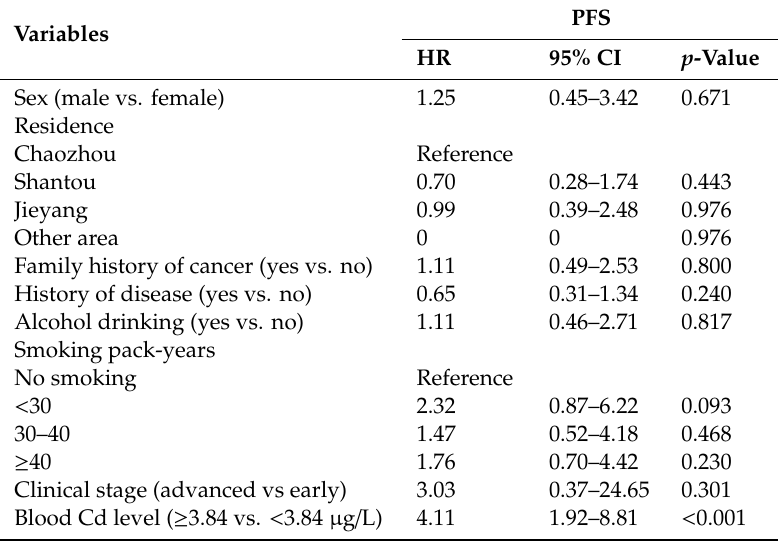
Figure 2. Comparison of PFS among different groups of NPC patients by Kaplan–Meier log-rank test. A–I: PFS by age, disease history, alcohol drinking, T classification, N classification, M classification, pathological type, early antigen-positive (EA+), and VCA, viral capsid antigen antibody-positive (VCA+), respectively (n = 134). Table 5. Proportional-hazards analysis of factors associated with progression-free survival (PFS) with NPC (n = 134).